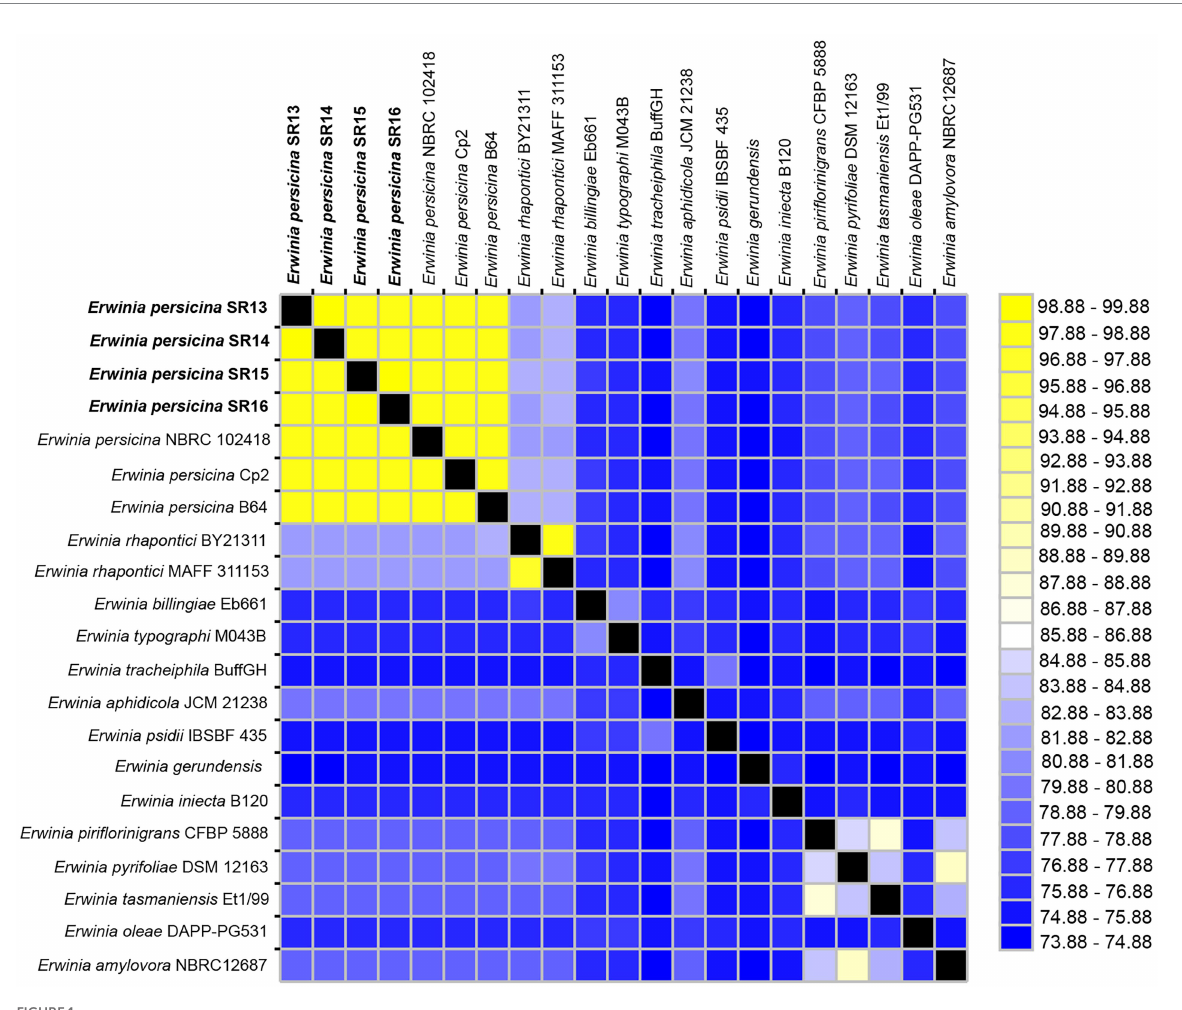
FIGURE 1 Average nucleotide identities (ANI) between Erwinia persicina SR13-16 and other Erwinia species. ANI analysis was conducted using the JSpeciesWS webserver with sequences from GenomesDB and NCBI. The heatmap was generated using JColorGrid. ANI values range from 73– 100% (blue to yellow). E. persicina SR13-16 are most similar to each other and to other E. persicina strains.